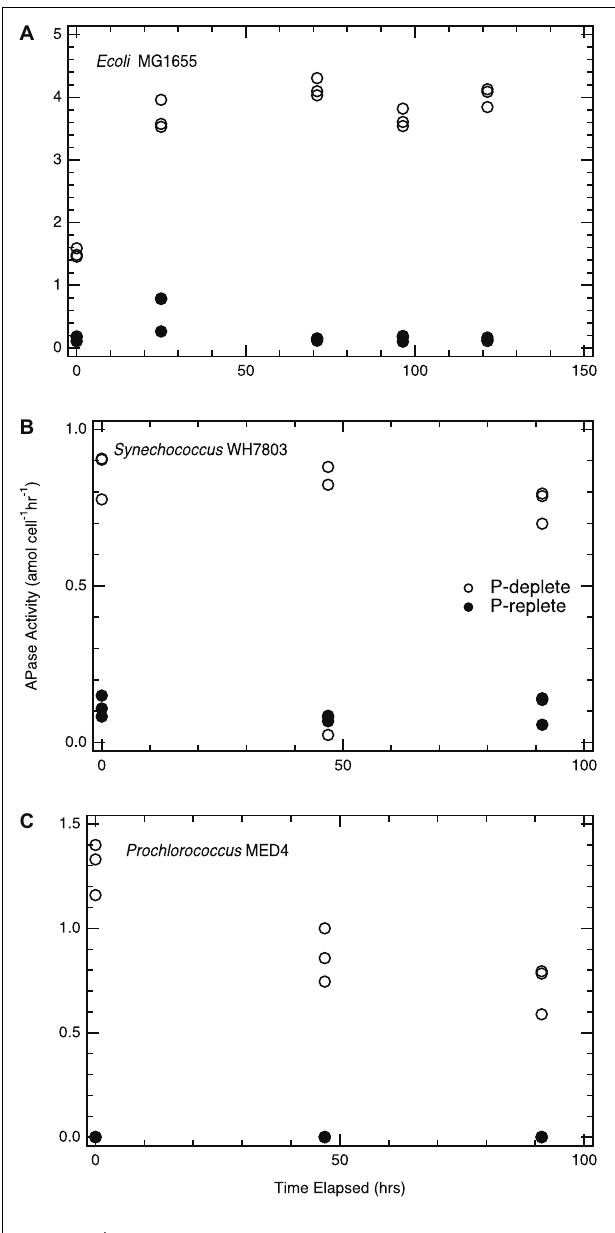
FIGURE 2 | Alkaline phosphatase activity following cell lysis. (A) E. coli ; (B) Synechococcus WH7803; (C) Prochlorococcus MED4. Filled circles, cells grown in P-replete conditions; open circles, cells grown in P-deplete conditions. DiFMUP concentrations for incubations were 10 µ M and all enzymatic rates are determined as maximum activities, where substrate is not deplete. For each time point, triplicate lysate incubations were measured, and the analytical error bars for each measurement are within the size of the symbols. Replete and deplete phosphorus conditions are statistically significant for the all the strains above; p <